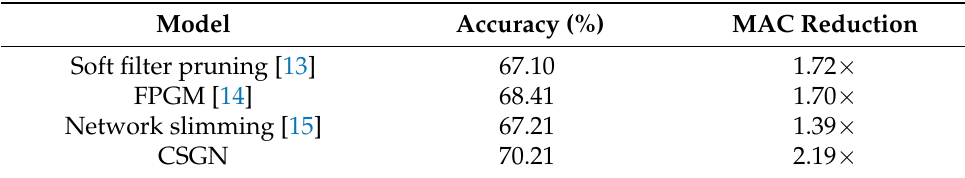
Table 9. In terms of top-1 accuracy and the amount of computation, comparison with static compres- sion with ResNet18 on ImageNet.